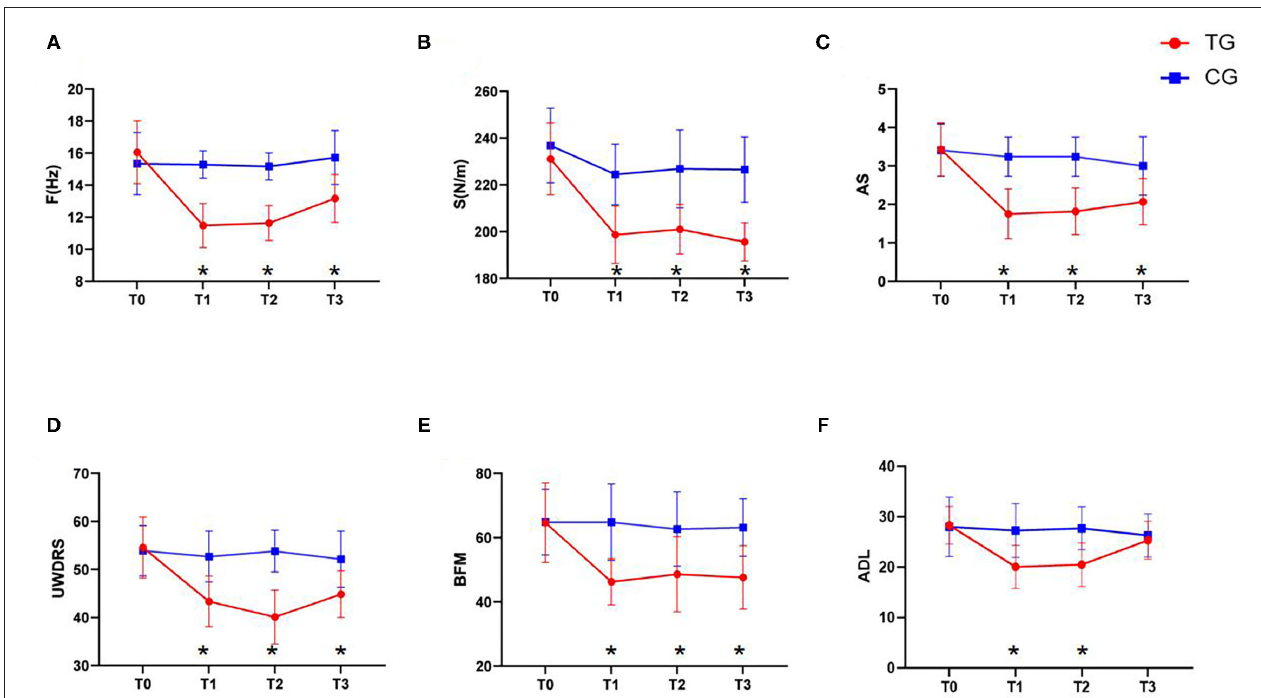
FIGURE 3 | Changes in clinical efficacy after rTMS. (A) The change of the F value. (B) The change of the S value. (C) The change of the UWDRS scores. (D) The change of the AS scores. (E) The change of the BFM scores. (F) The change of the ADL scores. Red: TG; blue: CG. Error bars represent SD; *represent significant difference between TG and CG at the same time